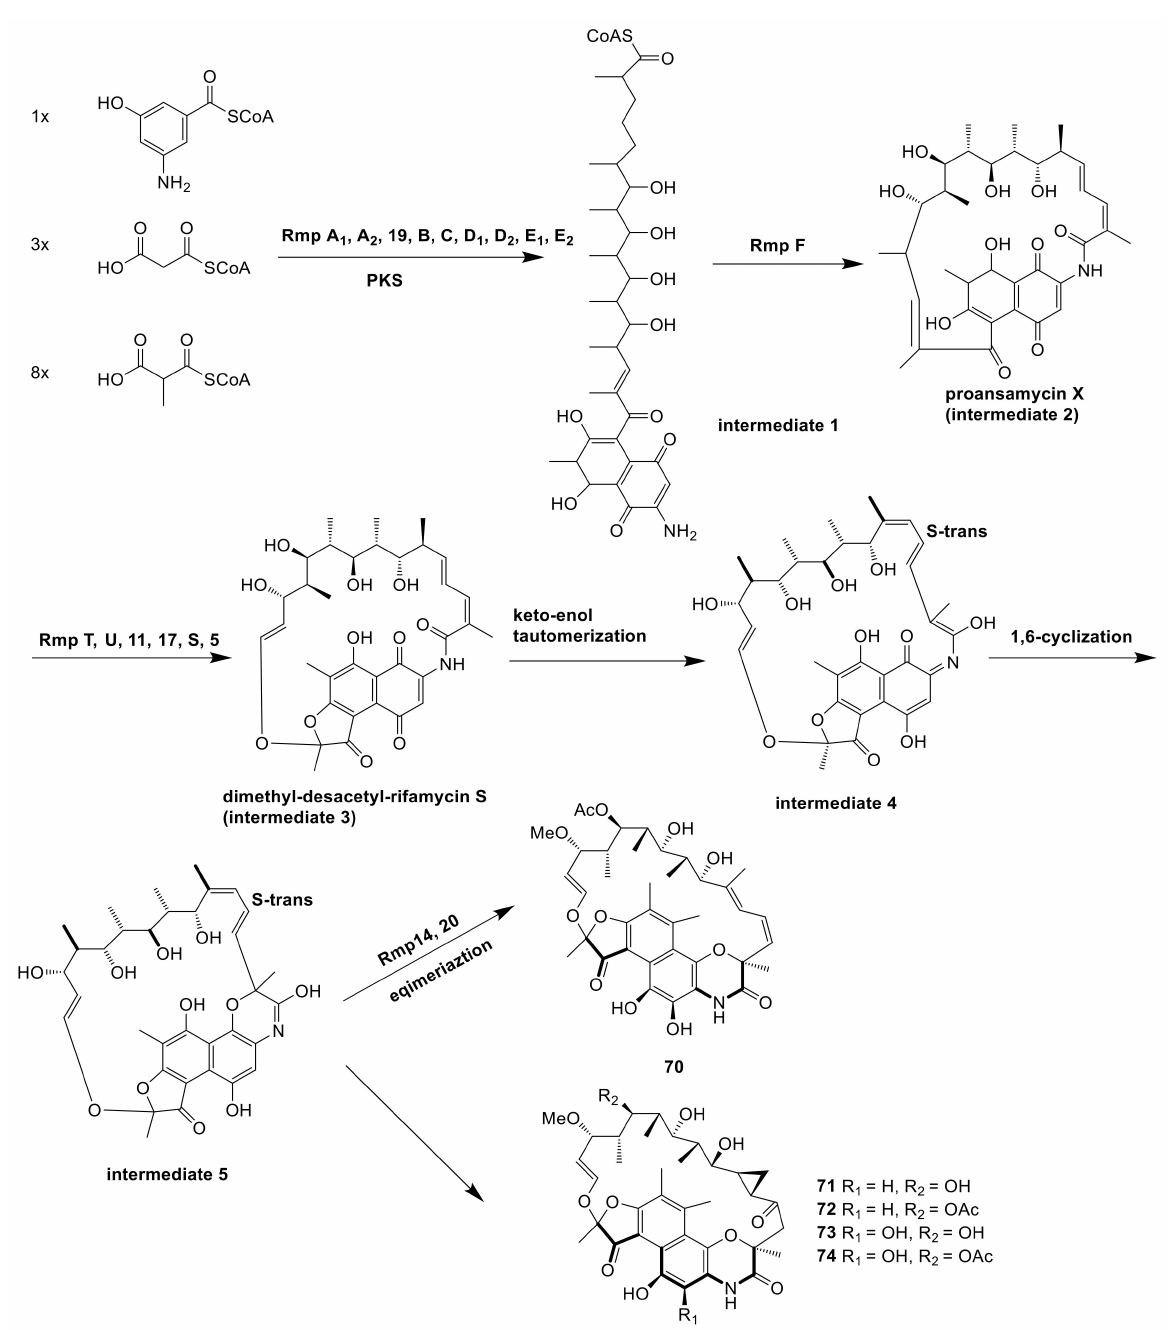
(Rmp 20) and C-27-O-methyltransferase (Rmp 14), as well as epimerization of C-21. However, the formation of compounds 71 – 74 was not speculated (Figure 10) [29].